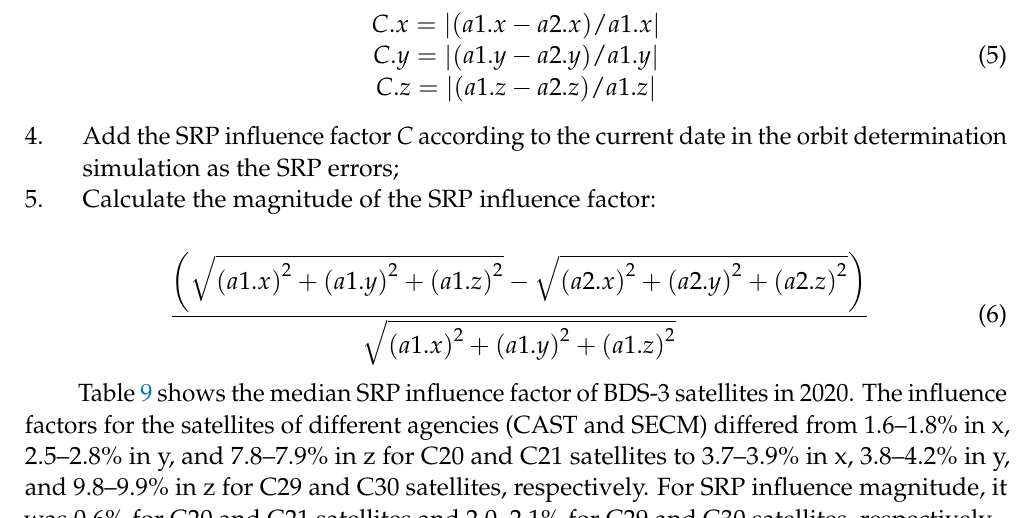
Table 10. The impact of SRP errors on orbit accuracy in the R, T, and N directions (unit: cm). PRN